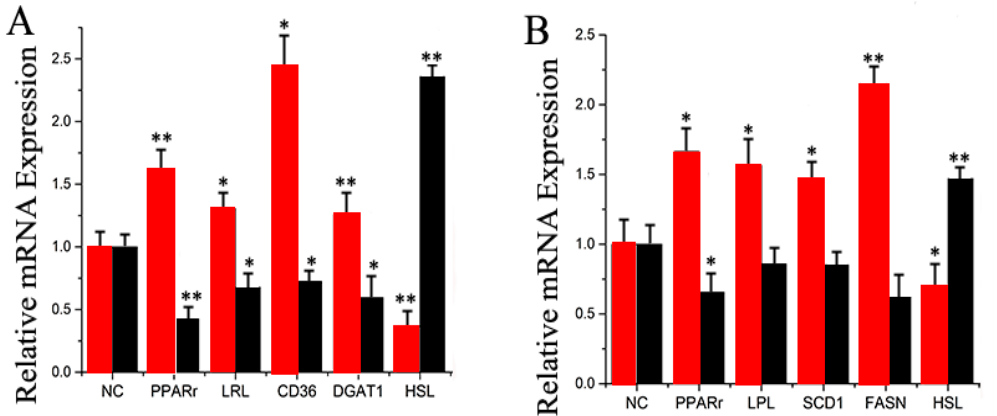
Figure 7. ( A ) Expression of fatty acid metabolism-related genes. The mRNA expression of PPAR γ , LPL , CD36 , DGAT1 , and HSL was quantified by RT-qPCR ( n = 6). Red bars represent the miR-30e-5p mimic; black bars represent the miR-30e-5p inhibitor; ( B ) Expression of fatty acid metabolism-related genes. The mRNA expression of PPAR γ , LPL , SCD1 , FASN , and HSL was quantified by RT-qPCR ( n = 6). Red bars represent the miR-15a mimic; black bars represent the miR-15a inhibitor. All experiments were duplicated and repeated three times. Values are presented as means ± standard errors, * p < 0.05; ** p < 0.01.